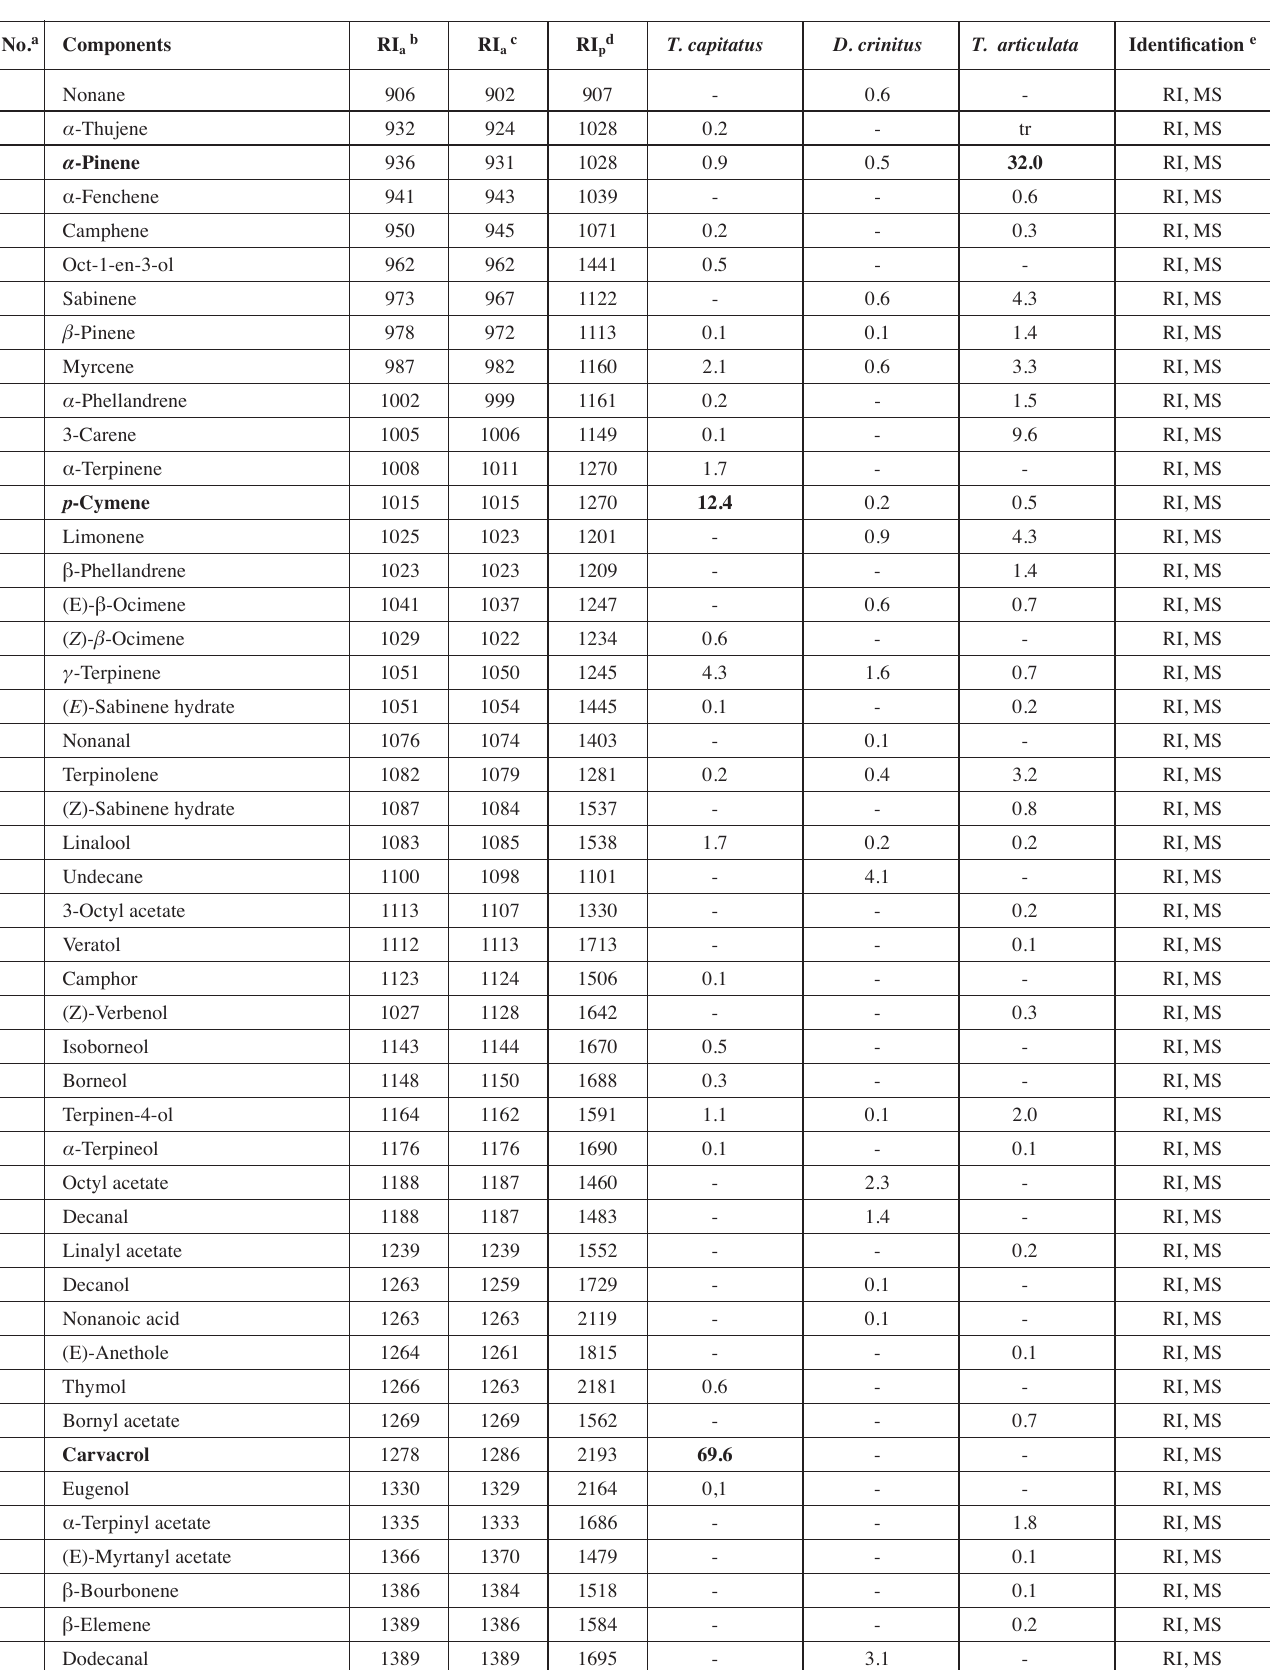
Tab. 1: Chemical compositions of aerial parts essential oils of T. capitatus, D. crinitus and T. articulate . No. a